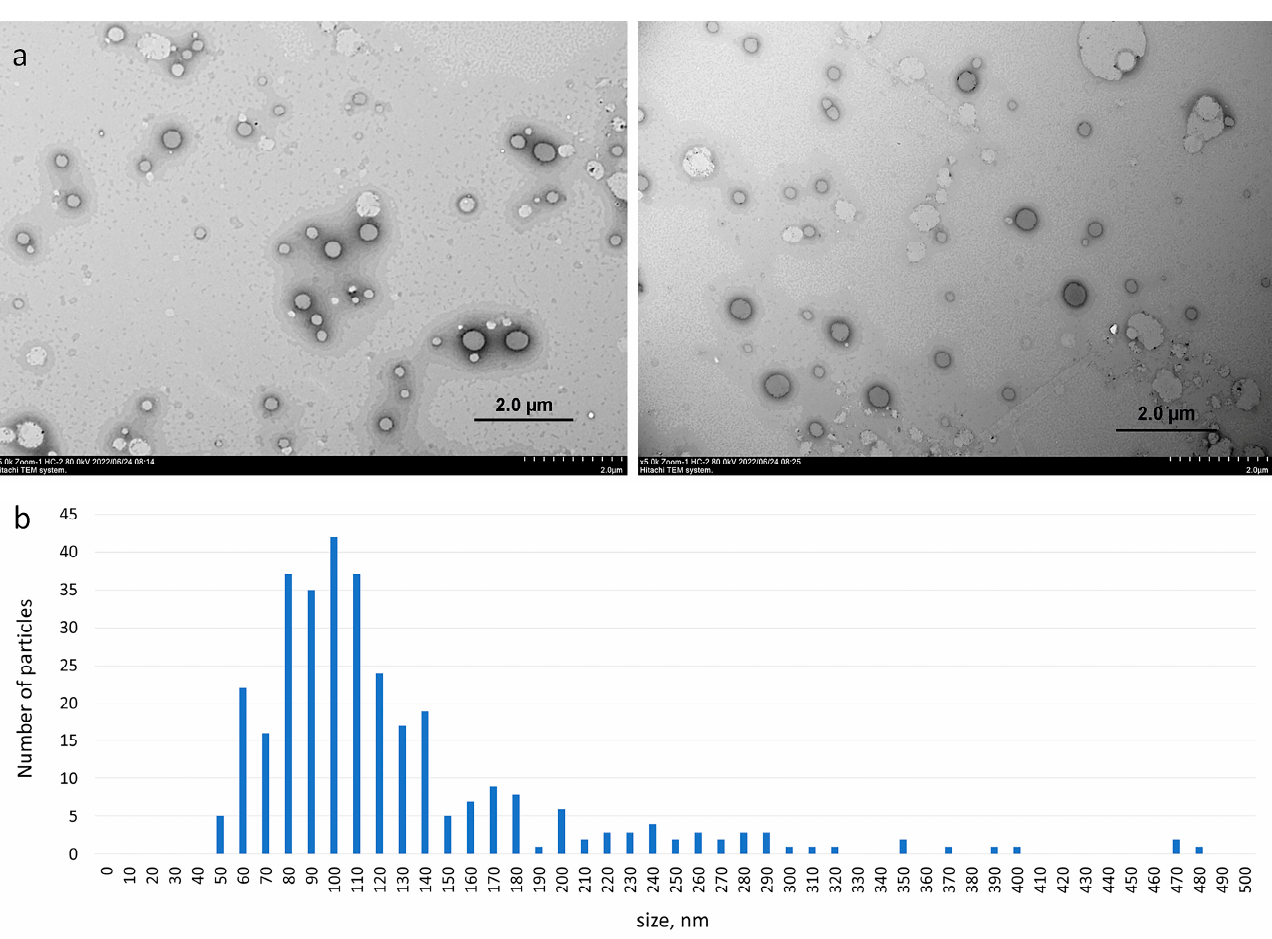
Figure 5. Transmission electron micrographs of VC10 – Hal ( a ) and the histogram showing the average particle size obtained from the TEM images using ImageJ software ( b ).